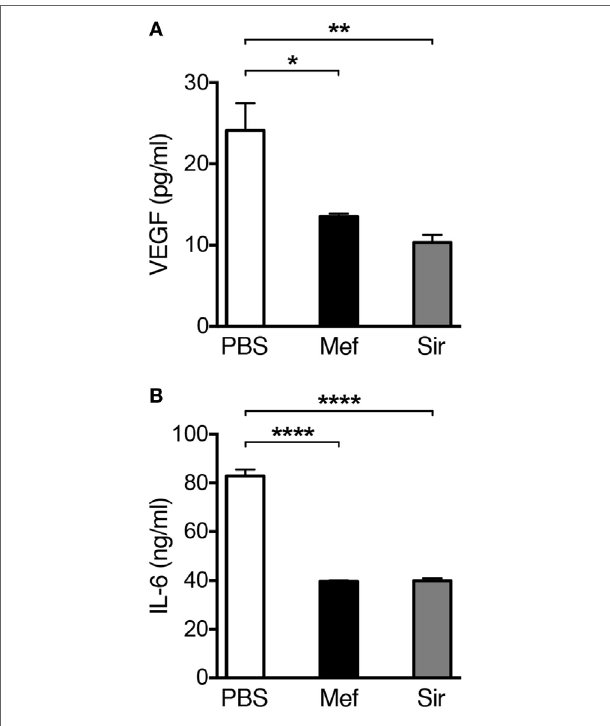
FigUre 5 | Treatment of human lung biopsies with mefloquine and/or siramesine reduces the levels of VEGF and IL-6. Human lung biopsies were incubated with 20 µM of mefloquine or siramesine or phosphate-buffered saline (PBS) for 6 h. Levels of (a) human VEGF and (B) IL-6 were measured in the supernatants by ELISA ( n = 3; representative of two independent experiments/two donors). Results are presented as mean ± SEM (* P < 0.05, ** P < 0.01, **** P < 0.0001).